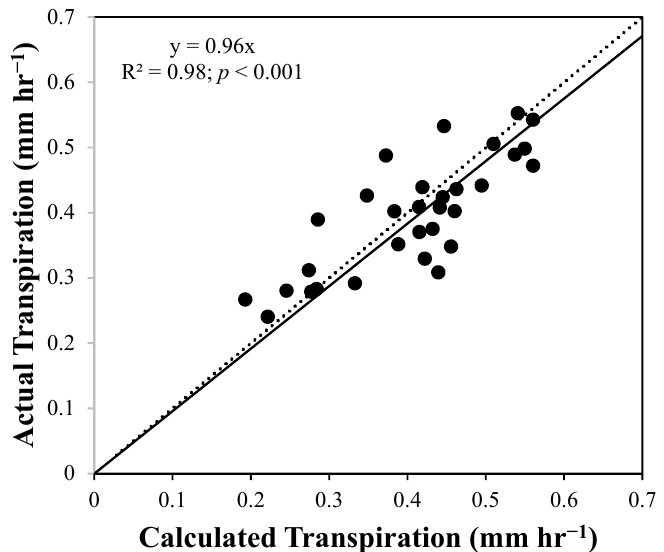
Figure 7. Relationship between actual and calculated transpiration (mm h − 1 ). The dotted line represents 1:1 equivalence and solid line is the fitted linear equation.